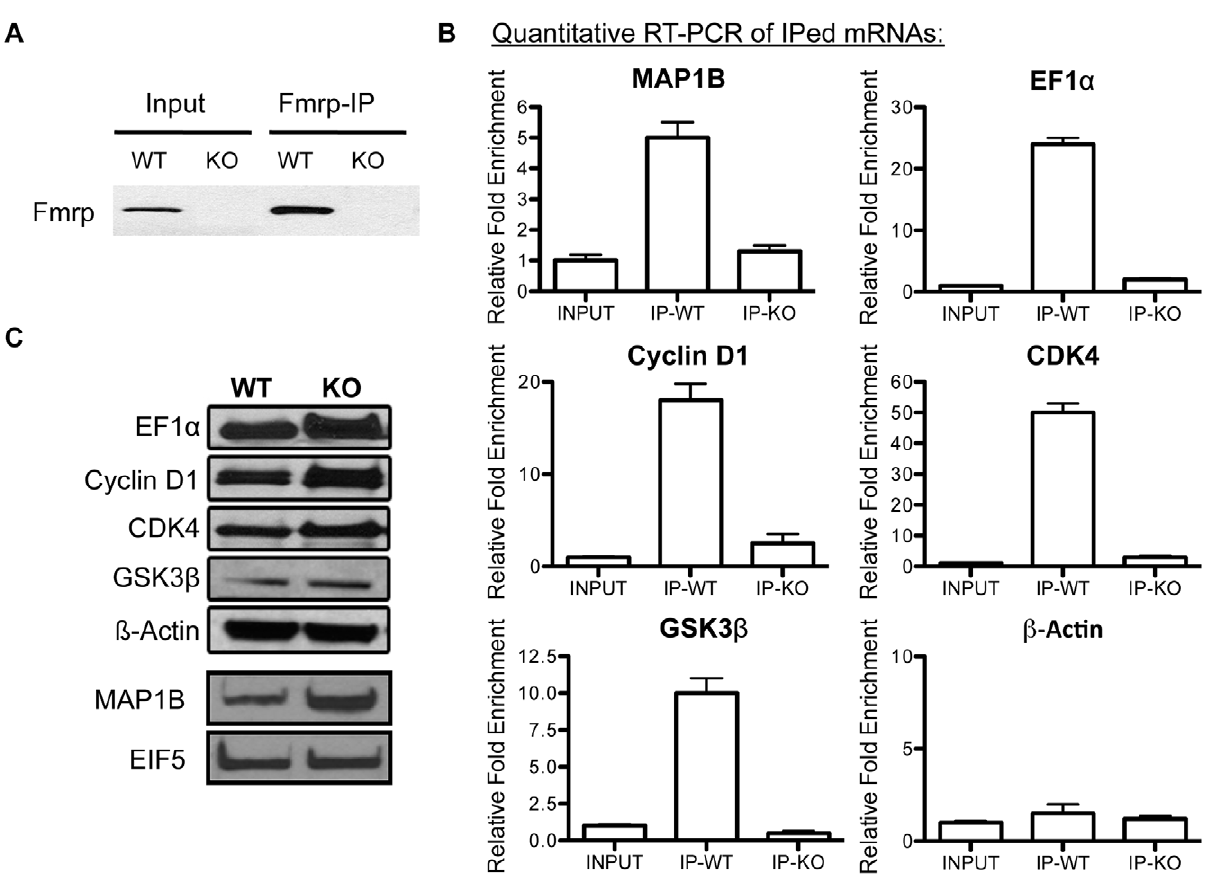
Figure 5. Identification of the mRNAs regulated by Fmrp in aNPCs. (A) Western blotting shows the amount of Fmrp in both input and immunoprecipitated Fmrp-containing mRNP complexes from both WT and Fmr1 KO aNPCs. (B) The RNAs from Input and from Fmrp-IP of WT and KO cells were isolated and subjected to cDNA synthesis and real-time PCR quantification. The results confirmed that Fmrp binds to the mRNAs of MAP1B, EF1a, CDK4, cyclin D1, and GSK3 b in WT aNPCs. KO aNPCs and ß-Actin mRNA analyses were used as negative controls. (C) Representative western blotting image showing the protein expression levels of the target genes of Fmrp in both WT and Fmr1 KO aNPCs. EIF5 was used as a loading control for MAP1B, and ß-actin was used as a loading control for the others in western blots. Quantification of western blot band intensities is shown in Figure S6A.